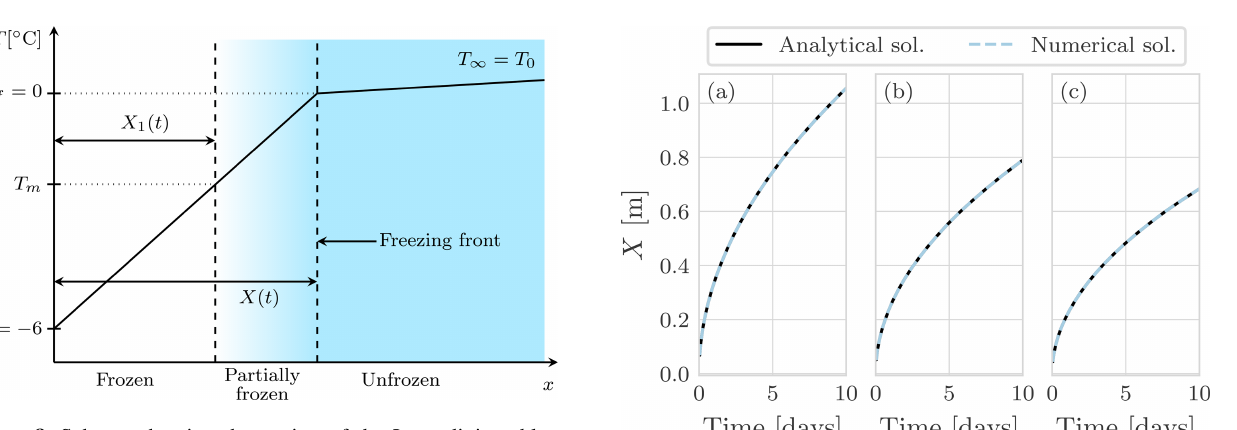
Figure 8. Scheme showing the setting of the Lunardini problem (Ruhaak et al., 2015). Initially the domain is unfrozen with T = T 0 . Because of T s < 0 on the left boundary, a freezing front propagates from left to right. X 1 (t) and X(t) identify respectively the isotherm corresponding to T m and T f .